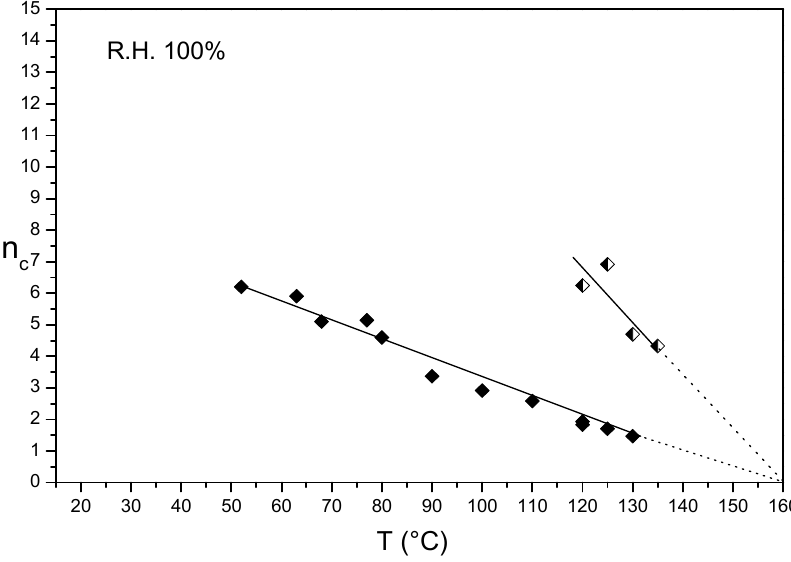
Figure 3. n c / T plot of semi-crystalline Aquivion ® 980 before ( full rhombus ) and after annealing at 150 °C in presence of DMSO for 7 days ( half empty rhombus ).